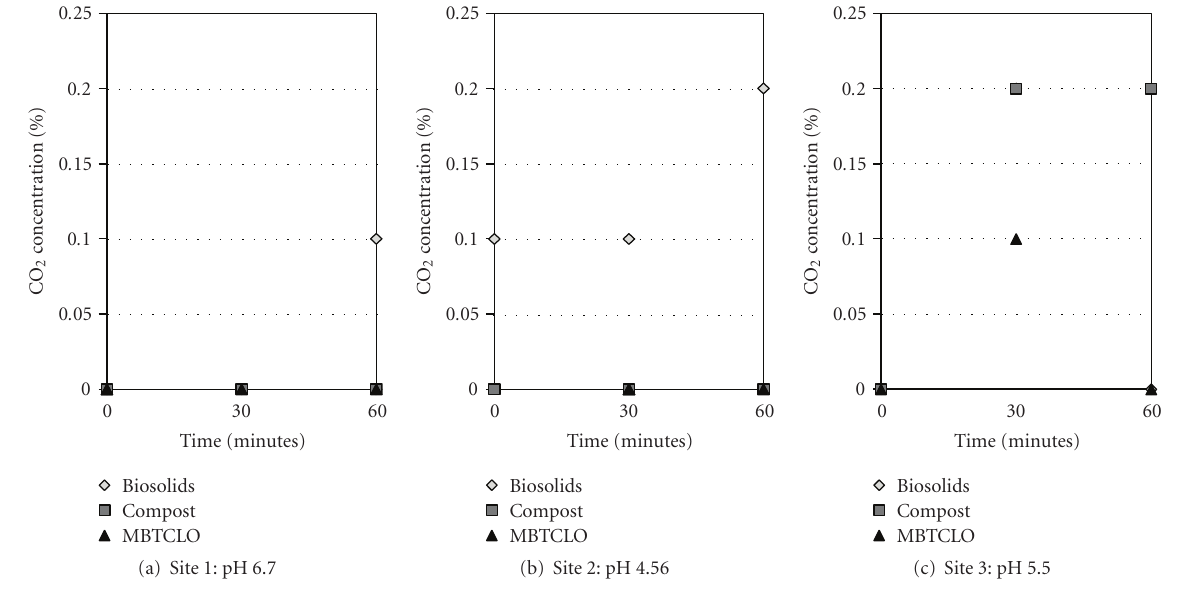
Figure 11: Measured CO 2